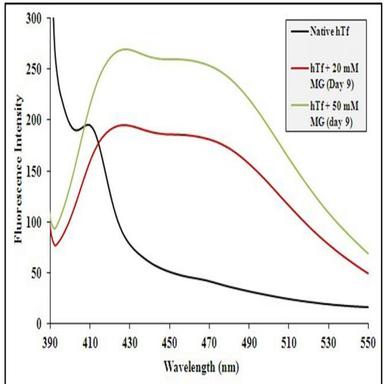
AGEs specific fluorescence. Fluorescence intensity of malondialdehyde-like AGEs formed upon incubating human transferrin with 20 mM and 50 mM MG for 9 days.